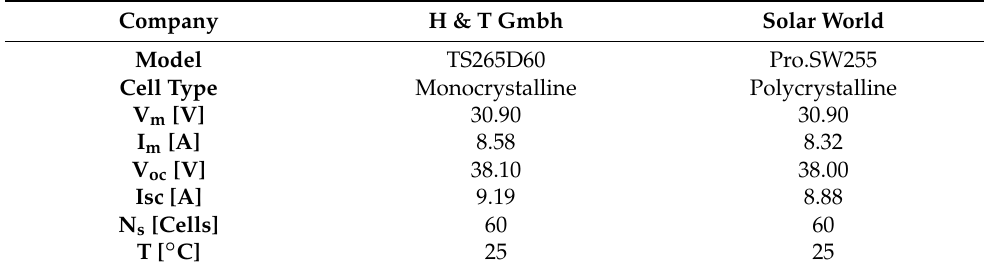
Table 3. Datasheet for two different types of PV cells.